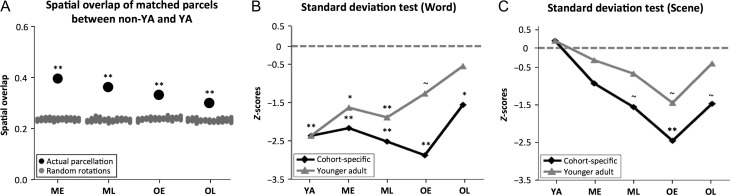
Spatial overlap of matched parcels between non-YA and YA cohorts declines with age; cohort-specific parcellations provide better estimates of task-evoked functional activity patterns relative to YA parcellation. (A) For each non-YA and YA cohort pair, the spatial overlap of matched parcels (black dots) are significantly higher than the spatial overlap of matched parcel rotations (the null model; gray dots). The distance between the black dot and gray dots, which was quantified by Zoverlap (see Materials and Methods), declines across age cohorts suggesting decreasing spatial overlap of parcellations. (B) During a word judgment task, the variance (SD) of mean functional activity data within cohort-specific parcels is significantly lower than null models, whereas there is no significant difference between YA parcellation and its null model in older cohorts. The dotted line denotes Z = 0 where the SD of cohort parcels equals the SD of their rotations (i.e., parcellations would exhibit the same performance as their null models). (C) During a visual scene judgment task, statistically significant differences are only present for OE cohort-specific parcels, although Z-scores of cohort-specific parcellations are lower than YA parcellations applied to non-YA cohort task data. Significance levels for spatial overlap analysis and standard deviation test: **P ≤ 0.01; *P ≤ 0.05; ~P ≤ 0.1.